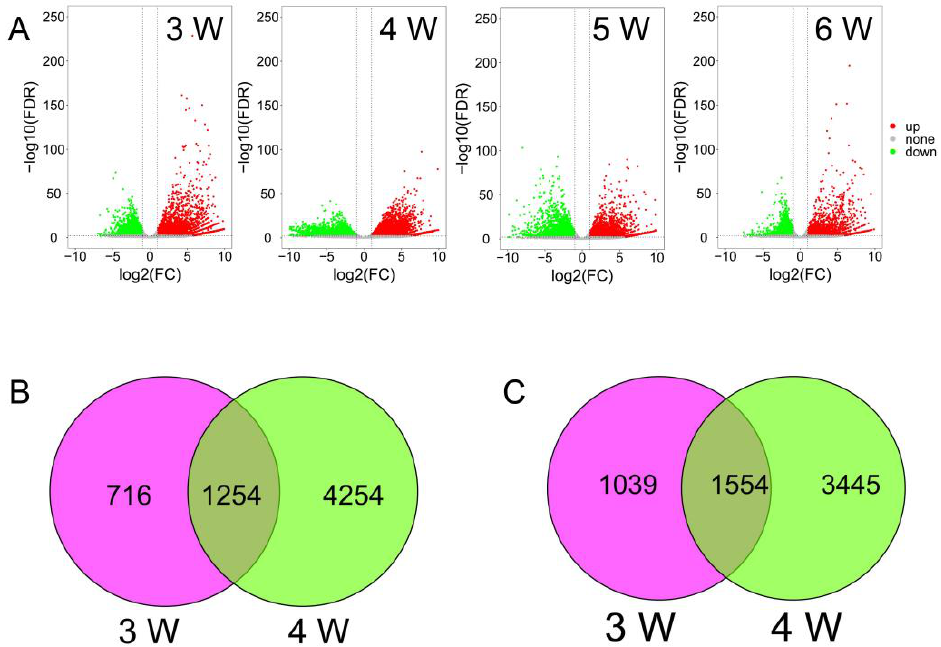
Table 1. DEGs at different growth stages of ‘BX’ and ‘RK’.